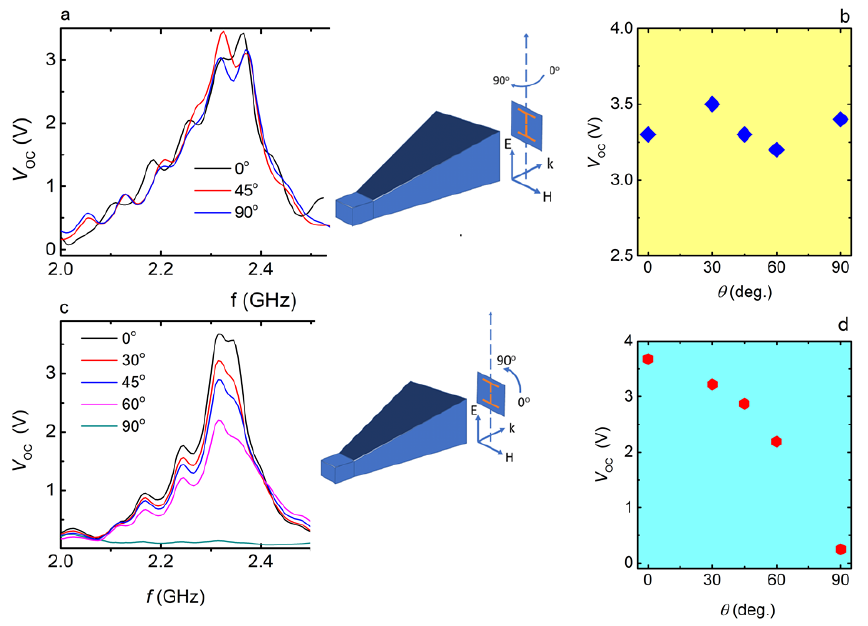
Figure 4. ( a ) Open circuit voltage as a function of frequency, for various θ = 0 ◦ (black line), θ = 45 ◦ (red line), and θ = 90 ◦ (blue line). The sketch shows the corresponding experimental configuration; ( b ) maximum open circuit voltage vs. angle θ ; ( c ) open circuit voltage as a function of frequency, for several φ angles. The sketch shows the corresponding experimental configuration; ( d ) maximum open circuit voltage vs. angle φ , as extracted from the main panel.